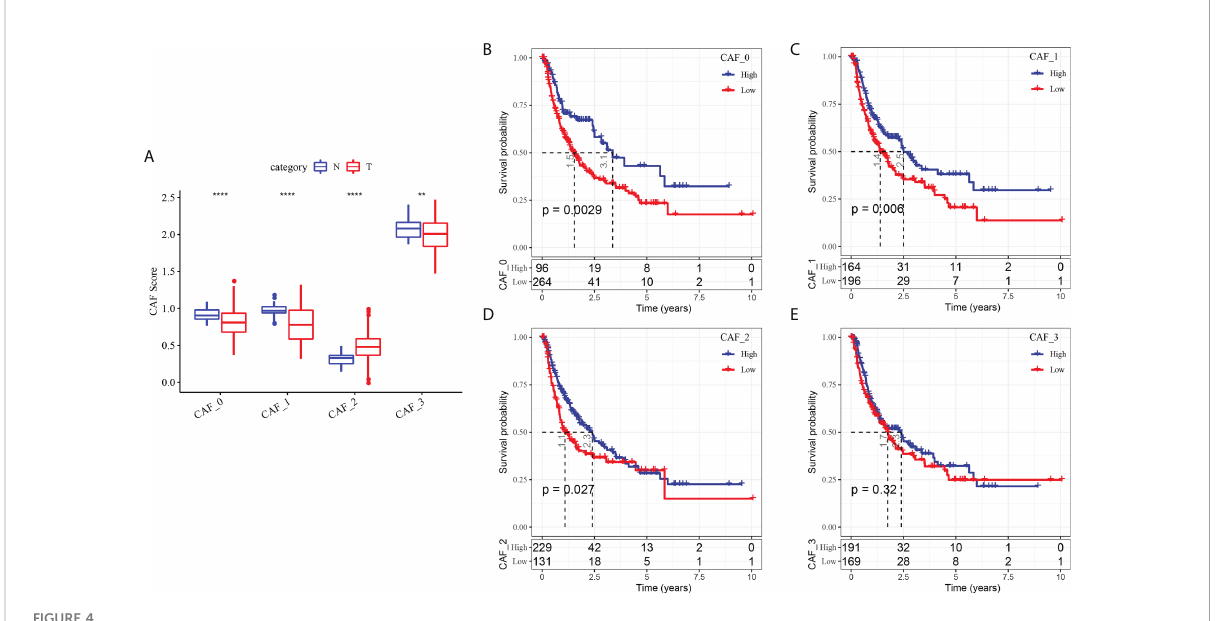
FIGURE 4 The associations between the four CAF cluster and prognosis of HCC patients. (A) Comparison of four CAF scores in cancer and normal tissues; K-M curves of the high and low CAF score groups in the CAF_0 cluster (B) , CAF_0 cluster (C) , CAF_0 cluster (D) , and CAF_0 cluster (E) . **P < 0.01, ****P <